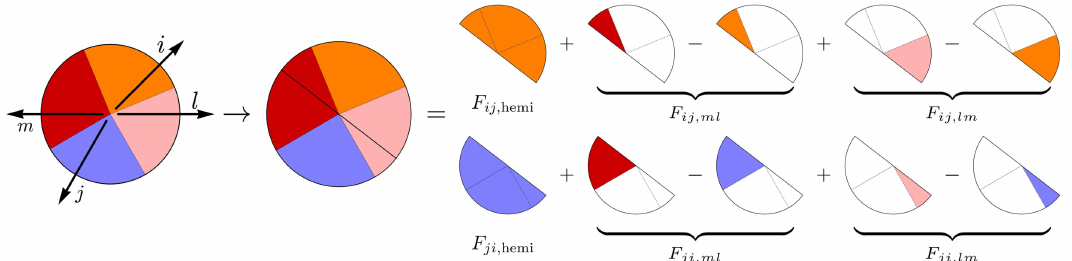
Figure 6 . The real soft contribution is decomposed into the hemisphere soft functions F ij, hemi and F ji, hemi and the non-hemisphere soft functions. The hemisphere functions contain all the divergences, while the non-hemisphere functions are finite. Here we focus on the hemisphere soft